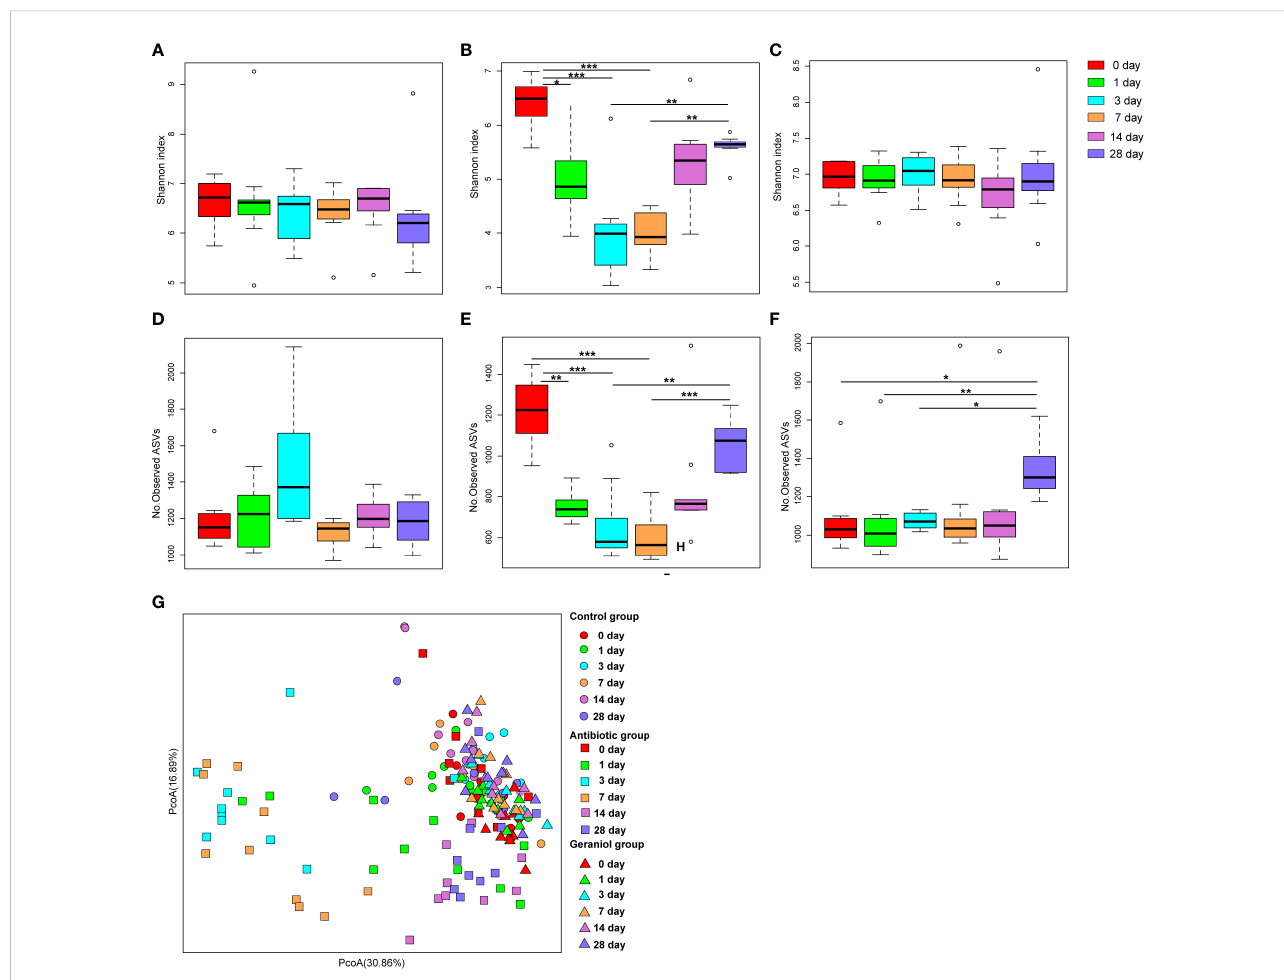
FIGURE 3 Dynamic changes of alpha and beta diversity of gut microbiotas in mice fed with saline, antibiotics and geraniol. Shannon index of gut microbiotas in mice fed with saline (A) , antibiotics (B) and geraniol (C) ; Number of observed ASVs of gut microbiotas in mice fed with saline (D) , antibiotics (E) and geraniol (F) ; (G) Principal coordinate analysis (PCoA) based on Weighted Unifrac distance of gut microbiotas in mice after being fed with saline, antibiotics and geraniol, separately. 0th means before the mice were fed with the drug; 1th day means 1 day after oral administration; 3th day means 3 days after continuous oral administration, and stopping oral administration; 7th, 14th and 28th day mean 7, 14, 28 days after oral administration, separately. (p values calculated by the One-way ANOVA test followed by post-hoc Dunn ’ s multiple comparisons test: ∗ < 0.05, ∗∗ < 0.01 and ∗∗∗ <